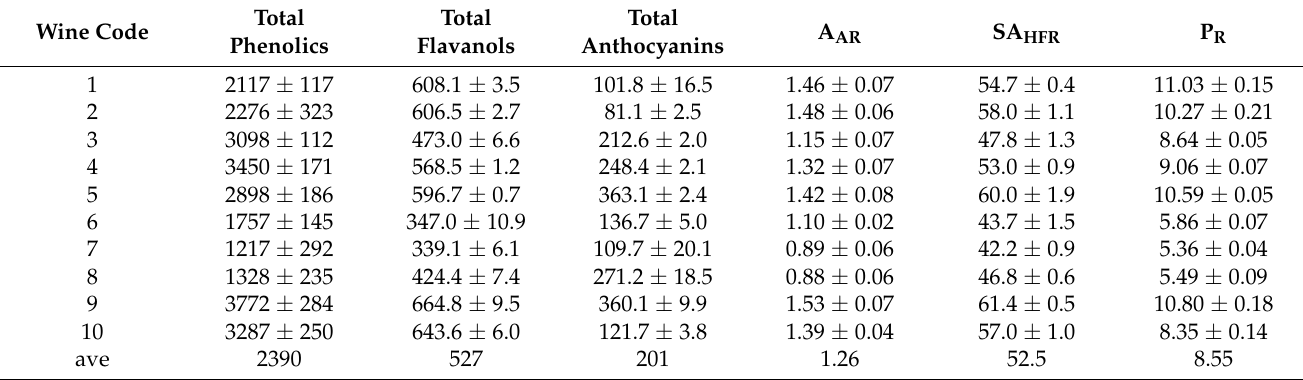
Table 1. Polyphenolic Composition and Antioxidant Properties of the Wines Examined [22].